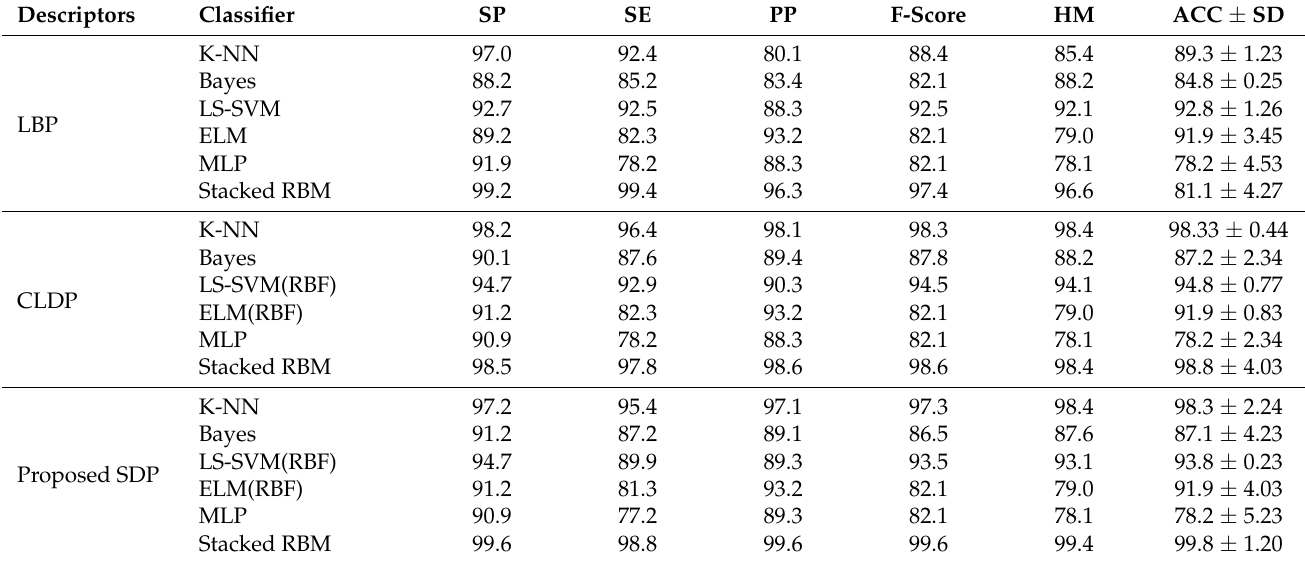
Table 3. Classification evaluation performance for the PH2.